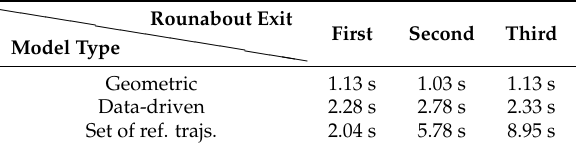
Table 4. Mean time (larger is better) from convergence to the correct exit direction until exiting from the roundabout.